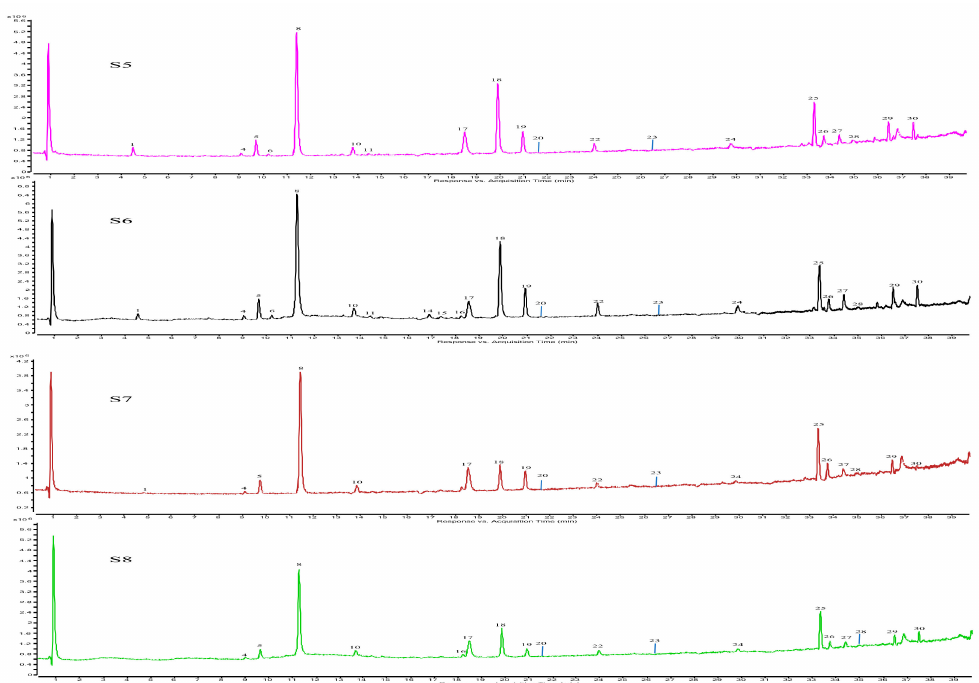
Figure 2. TIC chromatograms monitored in negative ion model fresh sample (S1) and shade drying